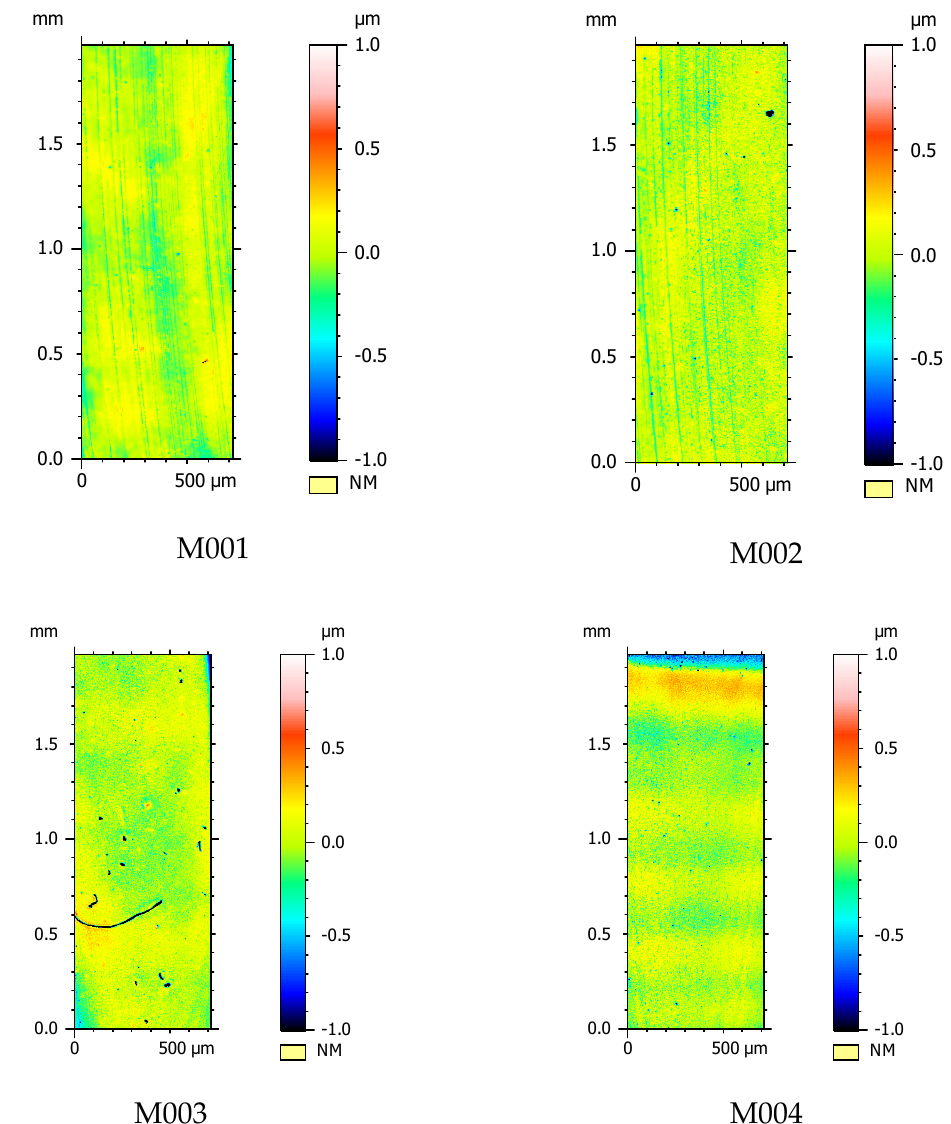
Figure 6. Exemplary scan of the V09 raceway surface after 3 h, 6 h, 9 h and 21 h of voltage-induced surface damaging.